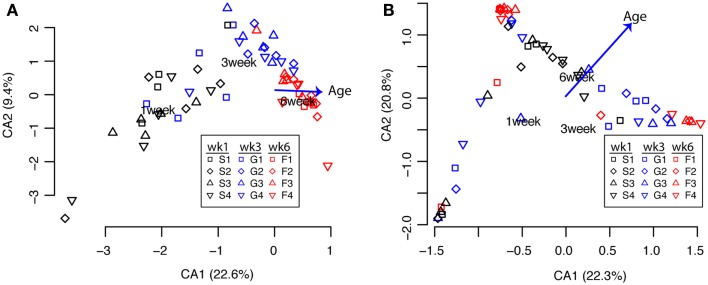
Clustering of cecal [(A), n = 59] and fecal [(B), n = 57] communities by bird age (weeks 1, 3, 6) or pen (1, 2, 3, 4). Each point represents the community from a single bird using 95% OTU classifications as described in the text. Clustering and environmental fitting of bird age was performed with the cca function in R; labels indicate the centroids of each bird age with vectors indicating the direction and magnitude of influence of the bird age relative to the axes.